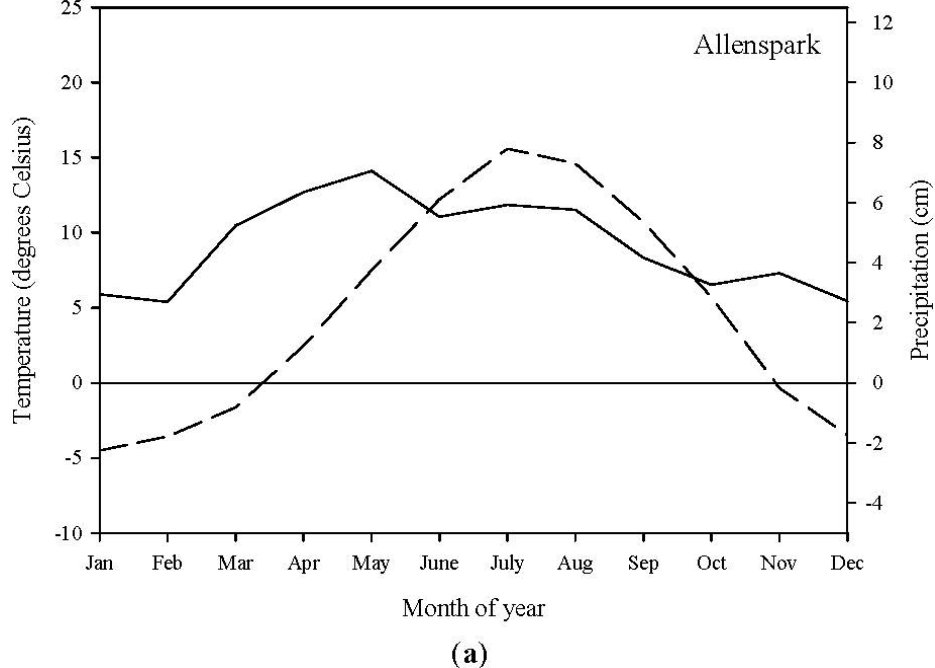
Figure 1. Monthly precipitation (cm, solid line) and mean temperatures (°C, dashed line) for Fort Collins ( b ); Boulder ( c ); Allenspark ( a ); and Cheesman ( d ) weather